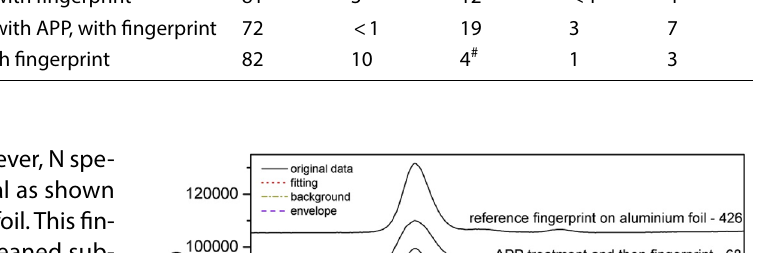
Table 3 C1s peak contributions (with binding energies given with an accuracy of ± 0.1 eV) as obtained by fitting XPS findings for green ABS-PMMA substrates that had undergone distinct intentional surface contamination and pre- treatment (# B.E. of 286.9 eV)